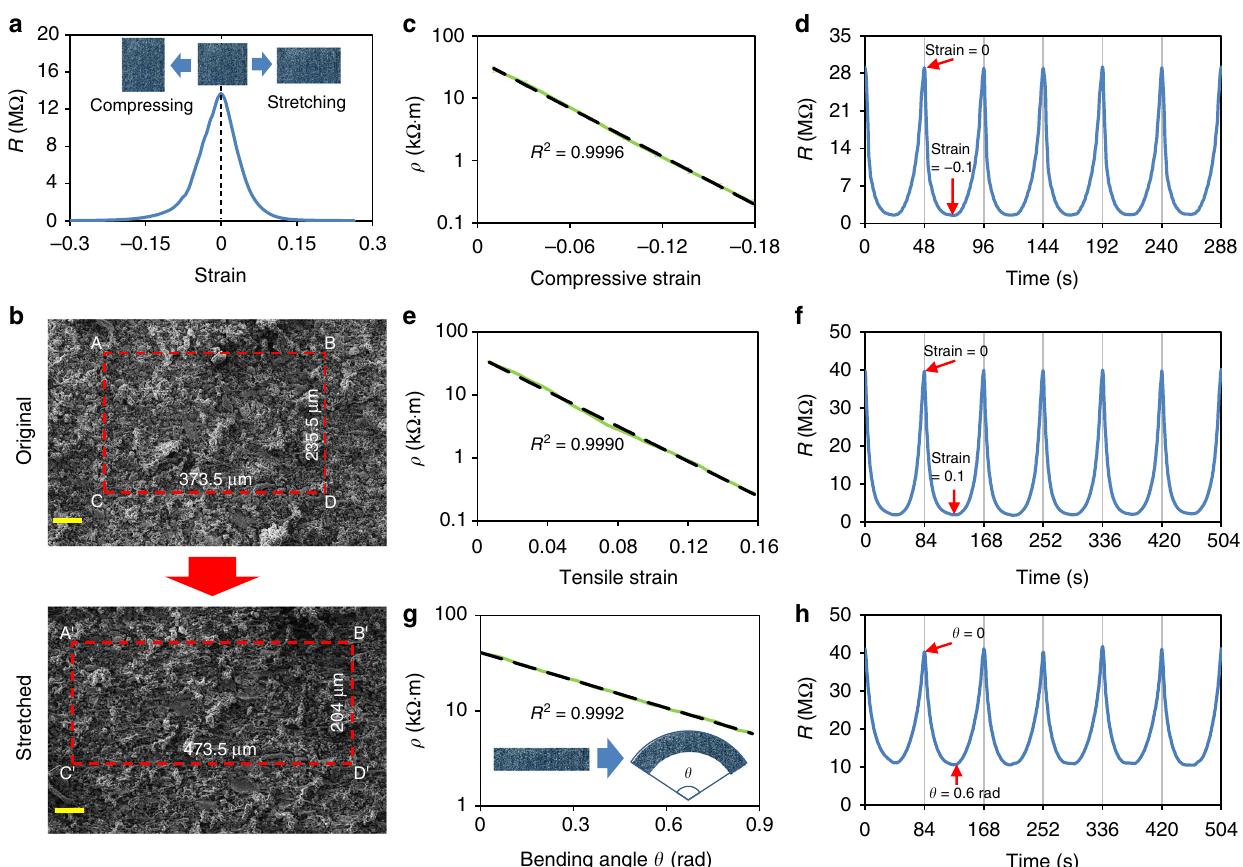
Fig. 2 Resistivity of the liquid metal- fi lled magnetorheological elastomer (LMMRE) upon the application of mechanical loadings. a Resistance-strain curve of the LMMRE. b Scanning electron microscopy (SEM) images of the LMMRE under relaxed and tensile conditions (scale bars are 100 µ m). Resistivity- strain curves and the resistance changes under cyclic loading under c , d compression, e , f stretching, and g , h